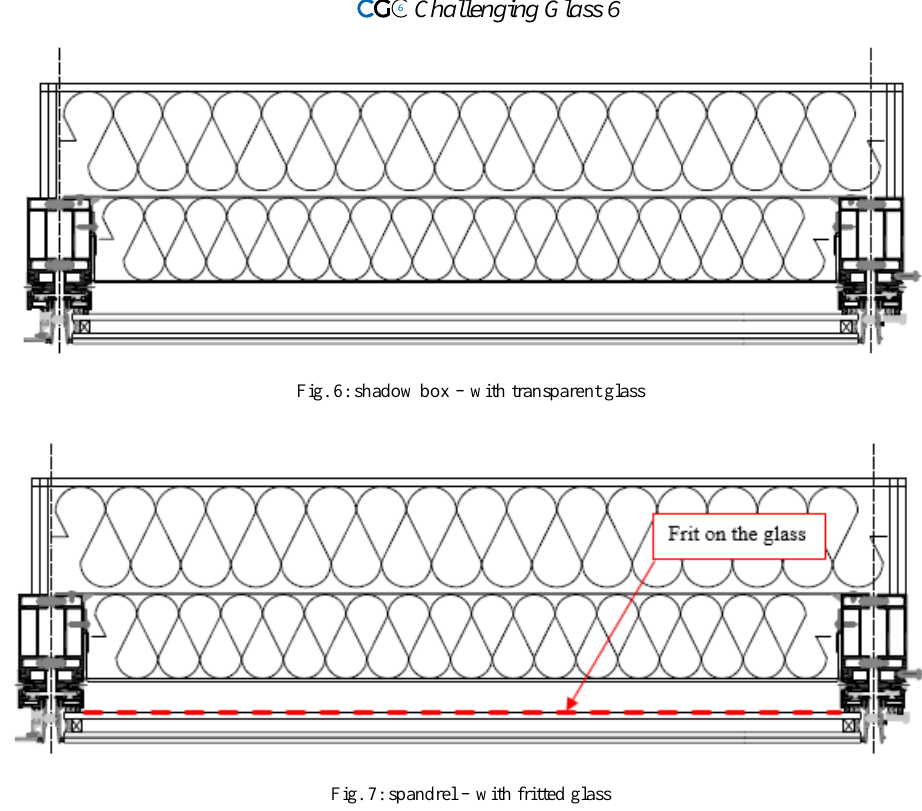
Fig. 7: spandrel – with fritted glass